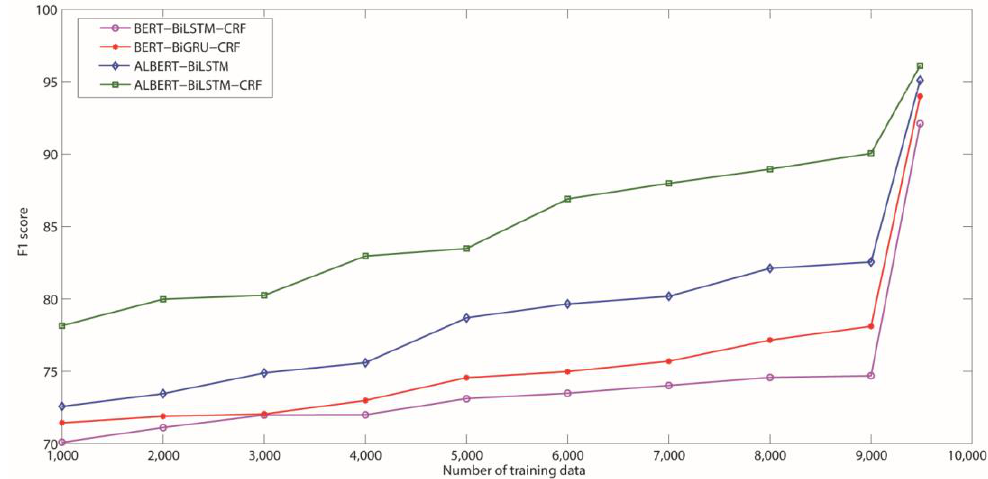
Figure 7. Average F1-score of the presented and baseline NER algorithms with different sizes of labeled data.